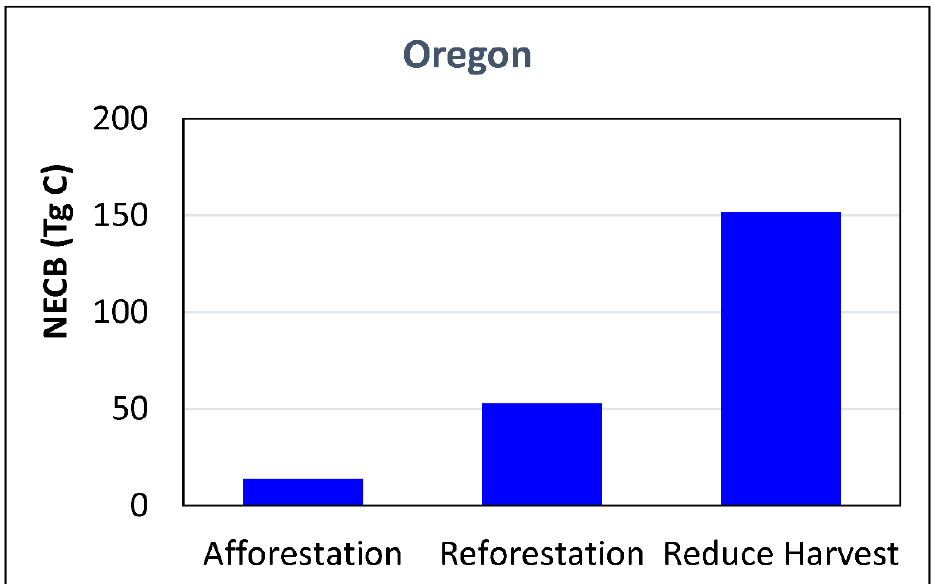
Figure 1. Land-use strategies to mitigate climate change across Oregon. Values on y -axis are cumulative change in net ecosystem carbon balance (NECB) from 2015 to 2100. Reduced harvest is a combination of restricted harvest by half on federal lands, and increased harvest intervals to 80 years on private lands. Data are from observation-based modeling [15].